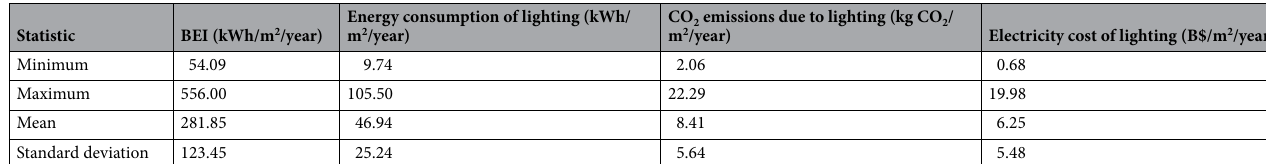
Table 1. Descriptive statistics of building energy intensity (BEI), energy consumption, CO 2 emissions and electricity cost of lighting for commercial buildings in Southeast